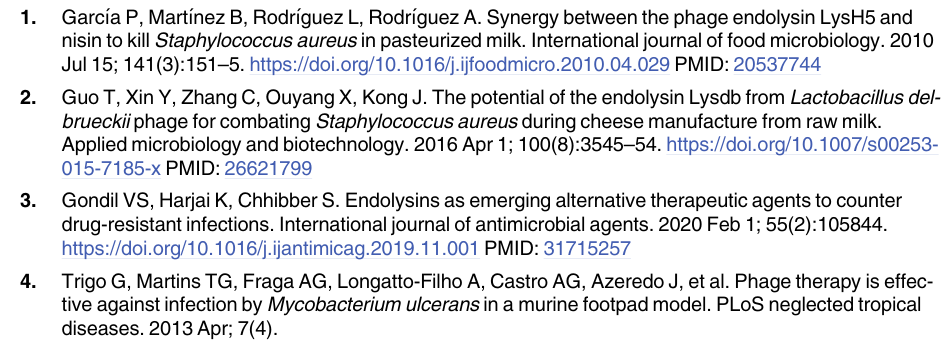
S1 Table. Annotation of Bacillus phage